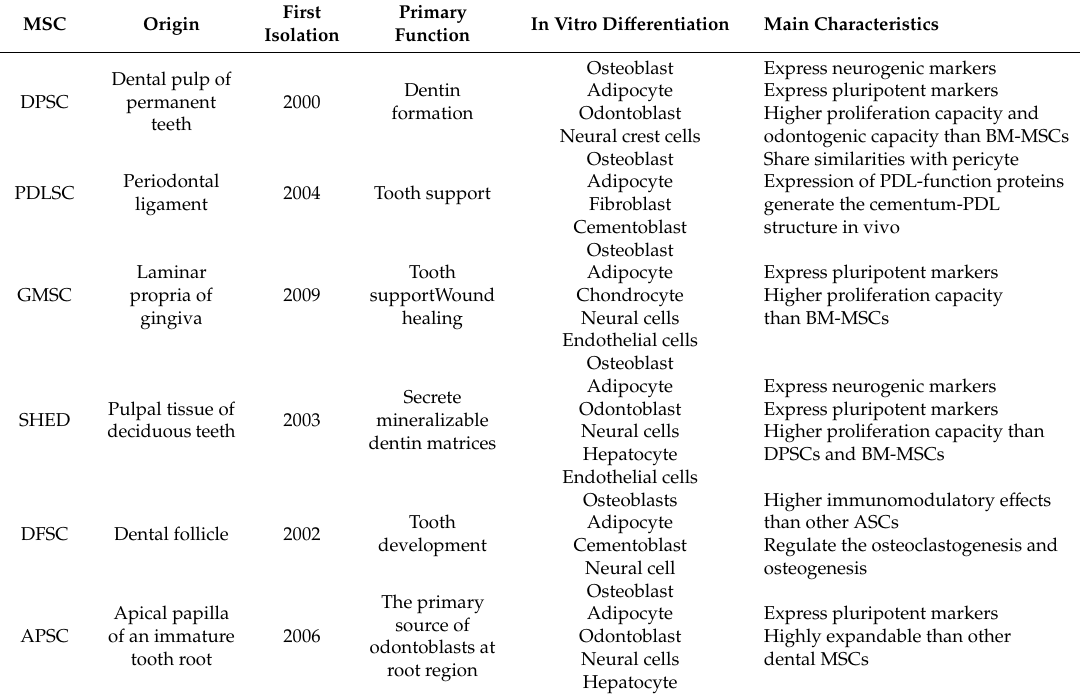
Table 1. Main characteristics of various dental mesenchymal stromal / stem cells